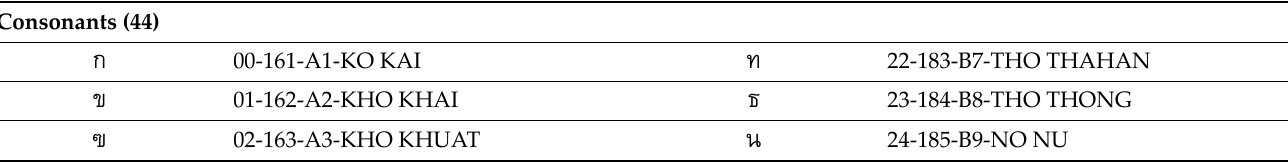
Table A1. Thai character classes considered for the dataset